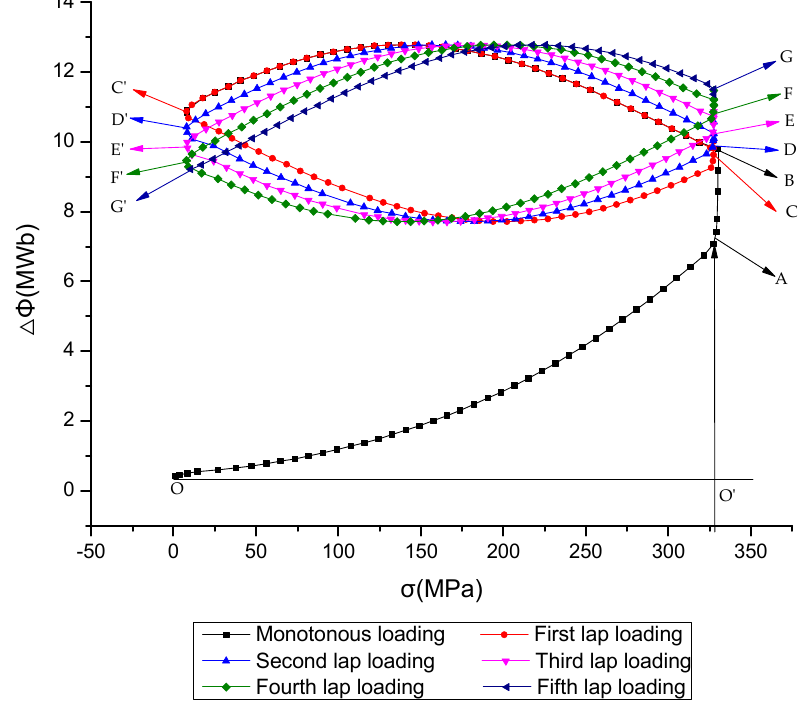
Figure 8. Magnetic stress flux curve of structural steels with diameters of 32 mm.